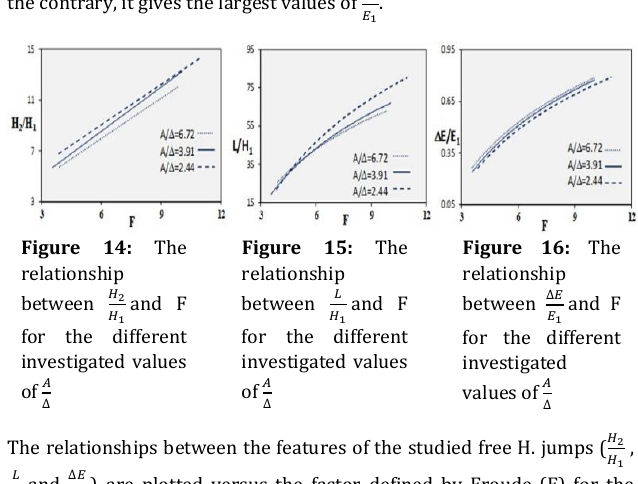
Figure 25: The relationship between the training values of the comparative lost energy Eq. (4) and the experimental measurements.